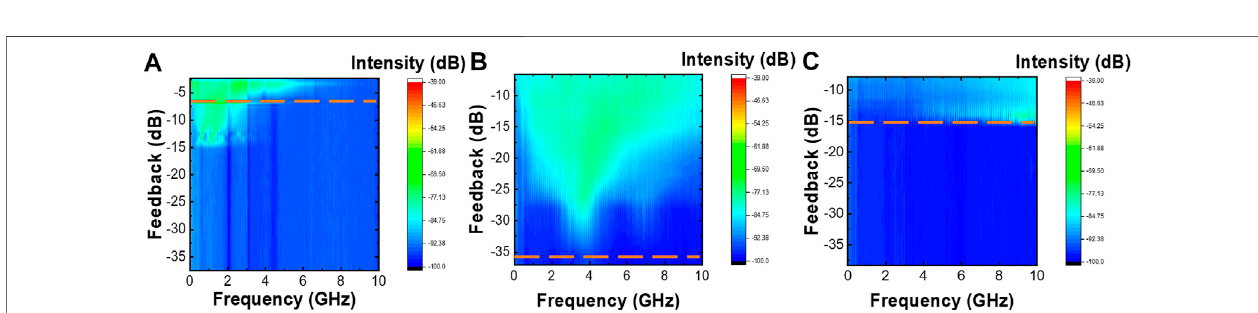
Frontiers in Materials |